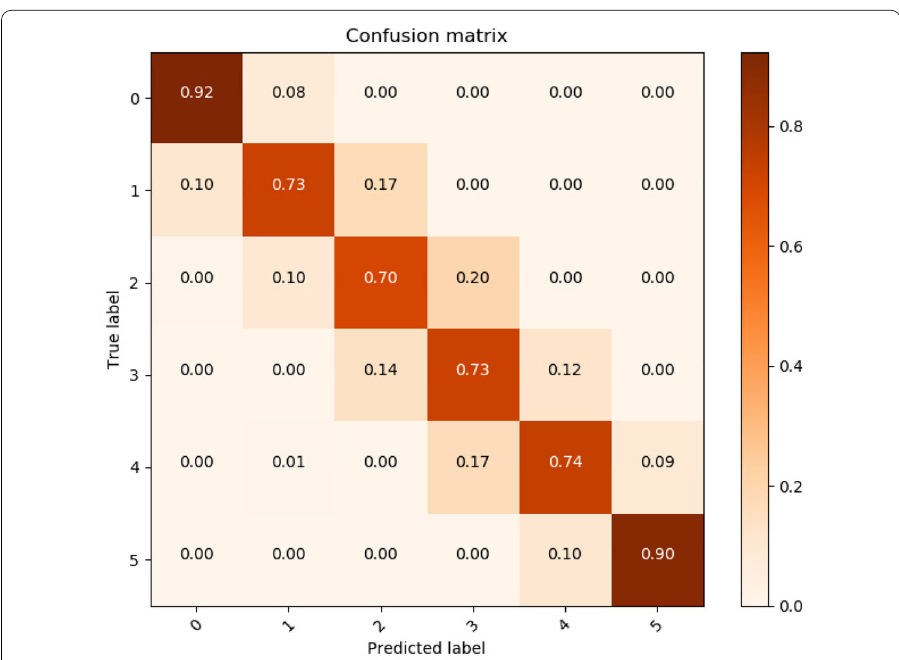
Fig. 9 Confusion matrix. Confusion matrix obtained on test data with the ensemble of